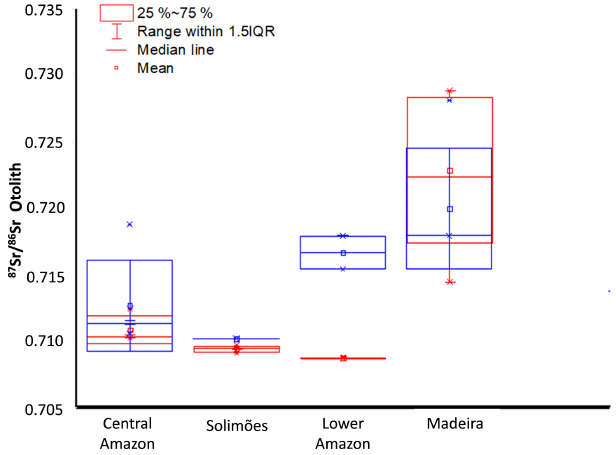
Figure 3. Box plot of otolith 87 Sr / 86 Sr ratio of wild (red) and farmed (blue) Arapaima spp. from four Amazonian